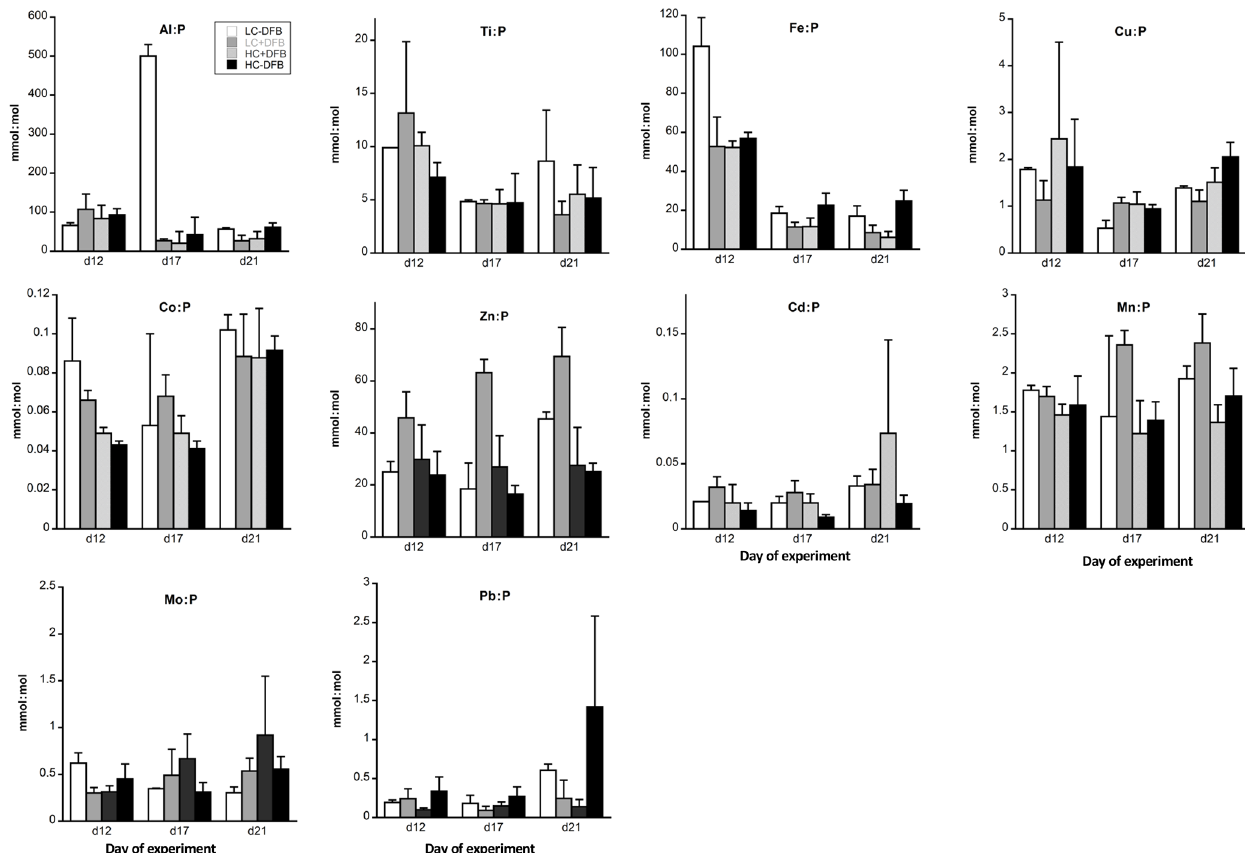
Figure 2. P-normalized metal quotas (mmol : molP) of particles from different treatments. LC: ambient CO 2 (390µatm); HC: increased CO 2 (900µatm). -DFB and +DFB are the ambient dFe and increased dFe during the development of a bloom of Emiliania huxleyi , respectively. Bars are means of measurements in three independent mesocosms ( n = 3) except for LC-DFB where n = 2. Error bars indicate SD.